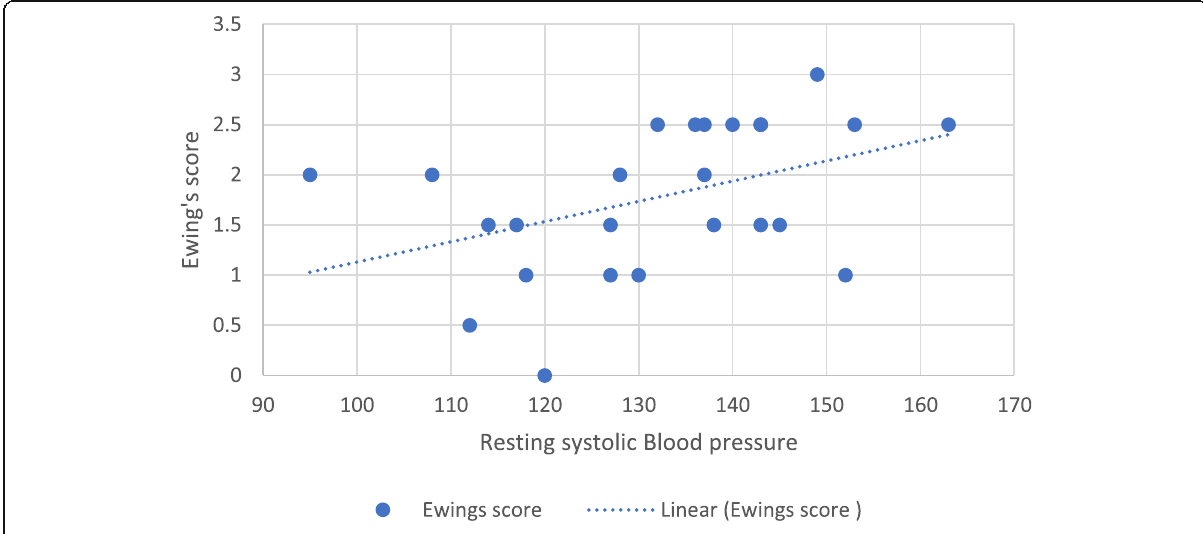
Fig. 2 Correlation between Ewing ’ s score and resting systolic blood pressure